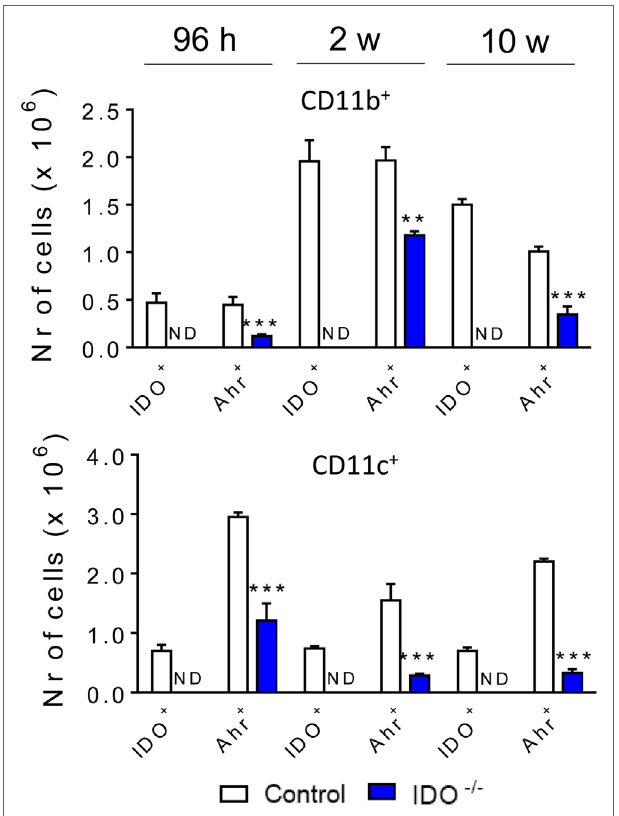
FigUre 5 | Indoleamine 2,3 dioxygenase-1 (IDO1) expression controls the levels of aryl hydrocarbon receptor (AhR) present in CD11b + e CD11c + cells. The number of IDO1 and AhR expressing cells was determined in lung infiltrating leukocytes of wild-type and IDO1 − / − mice 96 h, 2, and 10 weeks after infection with 1 × 10 6 viable Paracoccidioides brasiliensis yeasts. The lung cells were obtained as described in Section “Materials and Methods” and labeled with antibodies conjugated to different fluorochromes. The lung infiltrating leukocytes were gated by FSC/SSC analysis. The cells were gated for CD11b + or CD11c + and then for IDO1 and AhR expression. One hundred thousand cells were acquired on FACS CANTO II and subsequently analyzed by FlowJo software. Data are expressed as means ± SEM and are representative of three independent experiments using five mice of each mouse strain per group (** p < 0.01, and *** p <